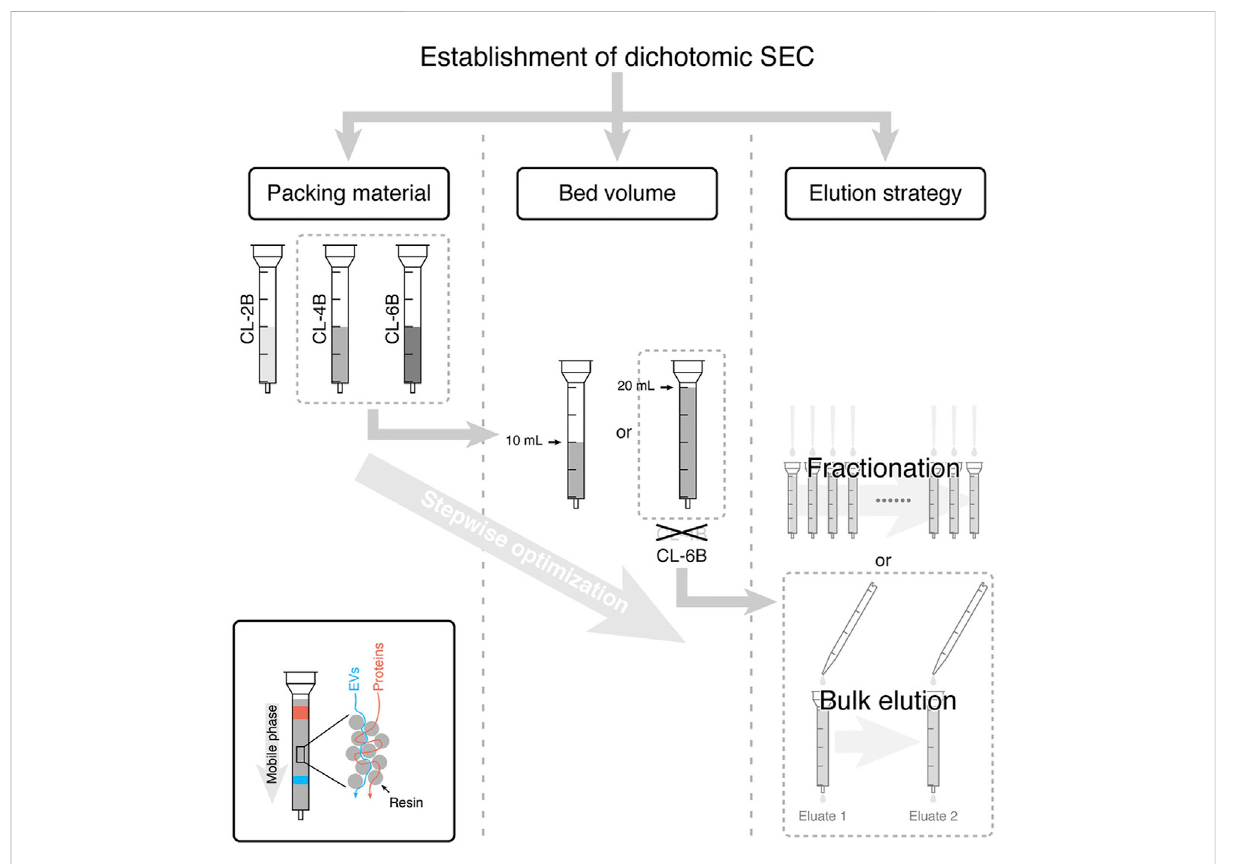
FIGURE 4 SEC-based EVisolation work fl ow and theunderlying principle. Inthisstudy,CL-6B was demonstrated tobethe best onefrom three Sepharose CL resins with the bed volume of 20 ml, and two bulk elution steps were suf fi cient for isolation of EVs. Reprinted with permission from Guo et al.